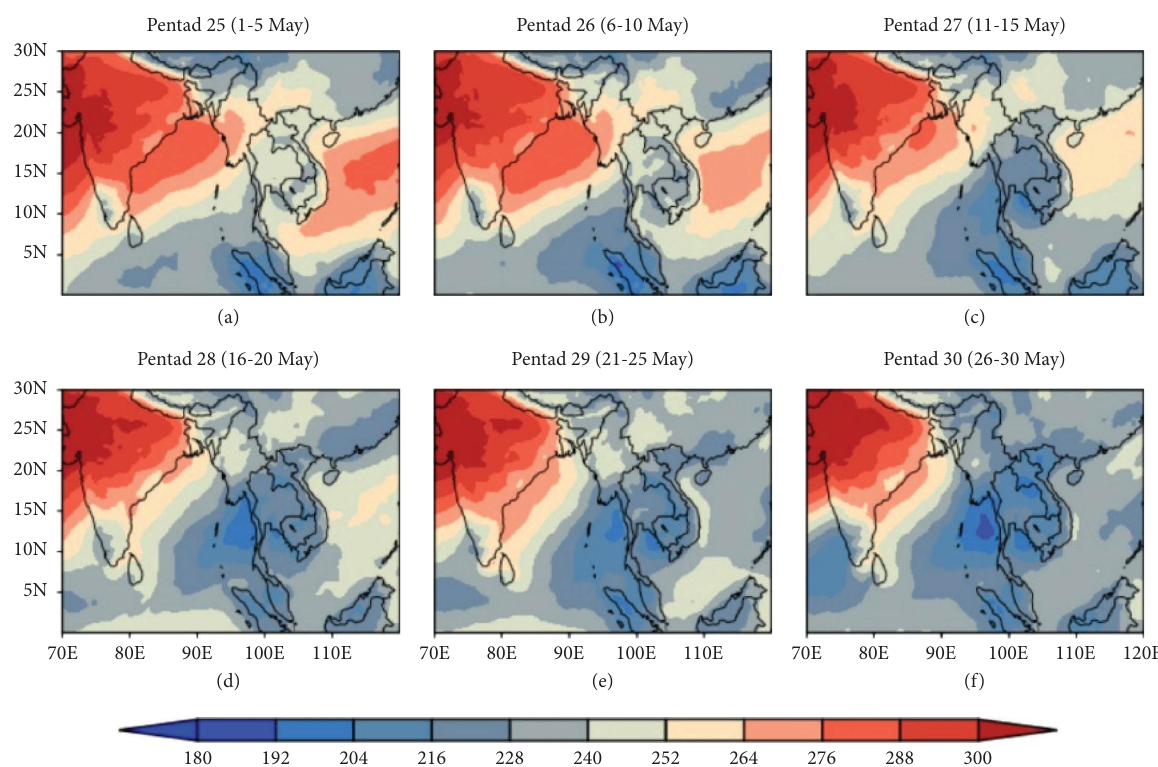
Figure 19: Composite of climatology (1991–2020) OLR (W m − 2 , colour) during the pentads (a) P -25 (May 1–5), (b) P -26 (May 6–10), (c) P -27 (May 11–15), (d) P -28 (May 16–20), (e) P -29 (May 21–25), and (f) P -30 (May 26–30) during the monsoon onset